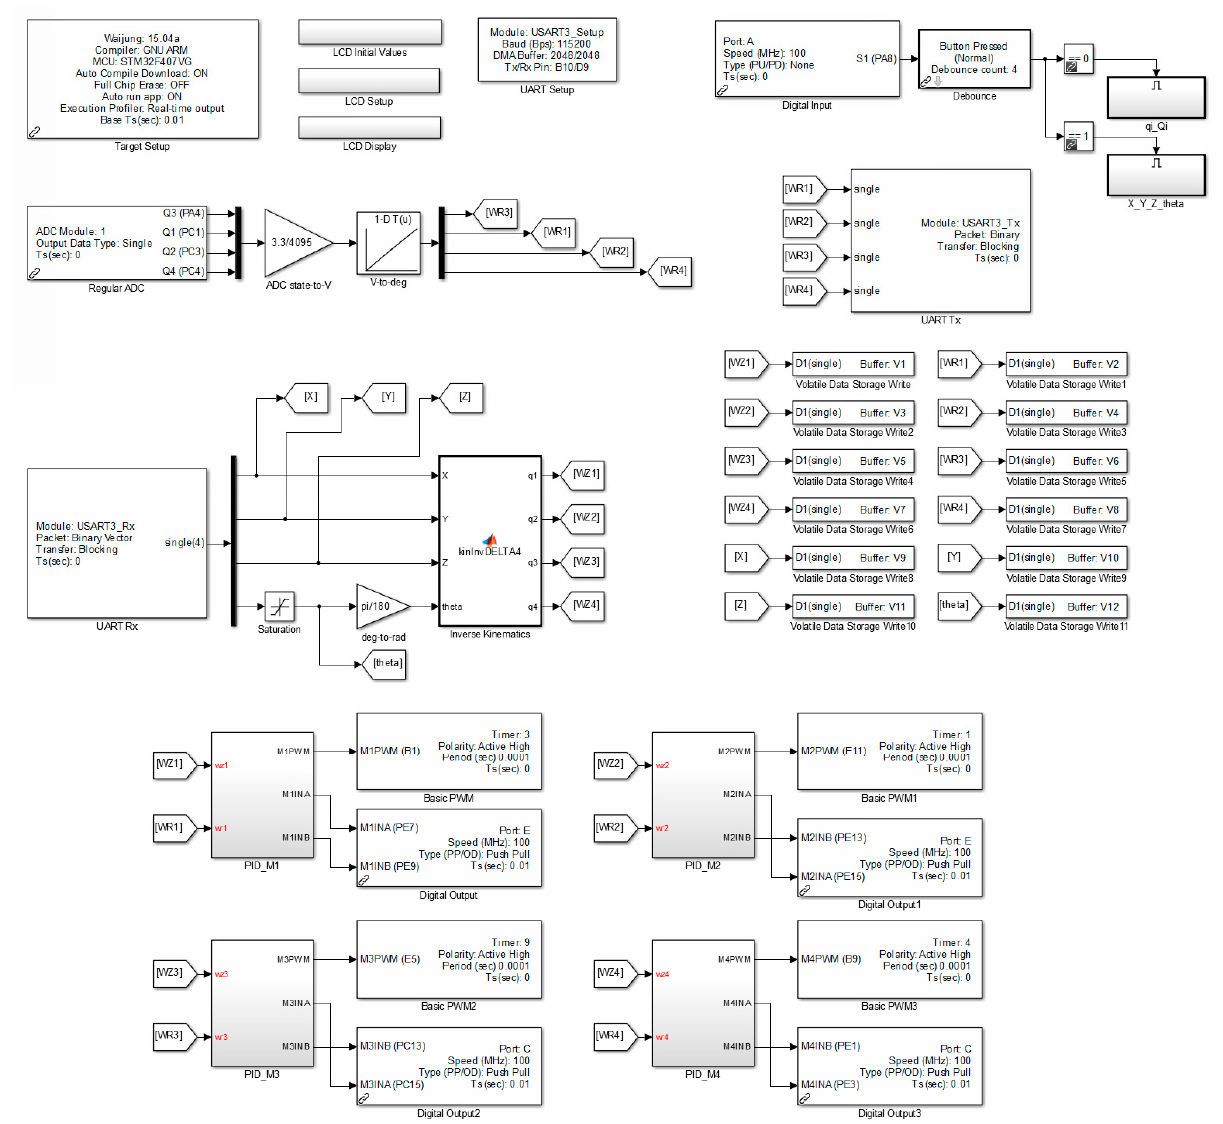
Figure 22. A flow chart of the algorithm of position and orientation control of the operating element of delta 4-DoF manipulator (Matlab/Simulink and Waijung Blockset).